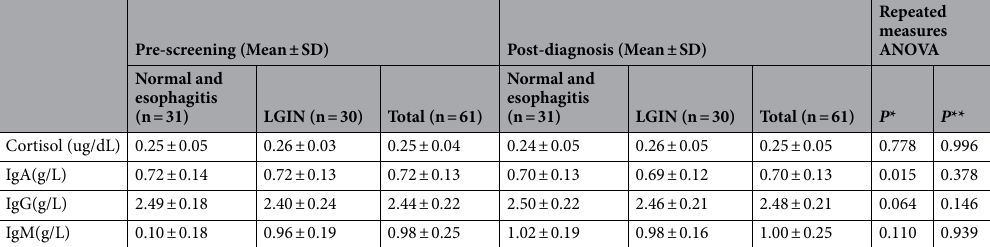
Table 2. Comparison of cortisol and immunoglobulin levels among participants at pre-screening and post- diagnosis: by esophageal pathology grades. Data did not show normal distributions were transformed using Box-Cox-power transformation. All values of λ are considered the optimal value for data is selected; the “optimal value” is the one that results in the best approximation of a normal distribution curve. LGIN Low- grade intraepithelial neoplasia. *Main effect. **Interaction with